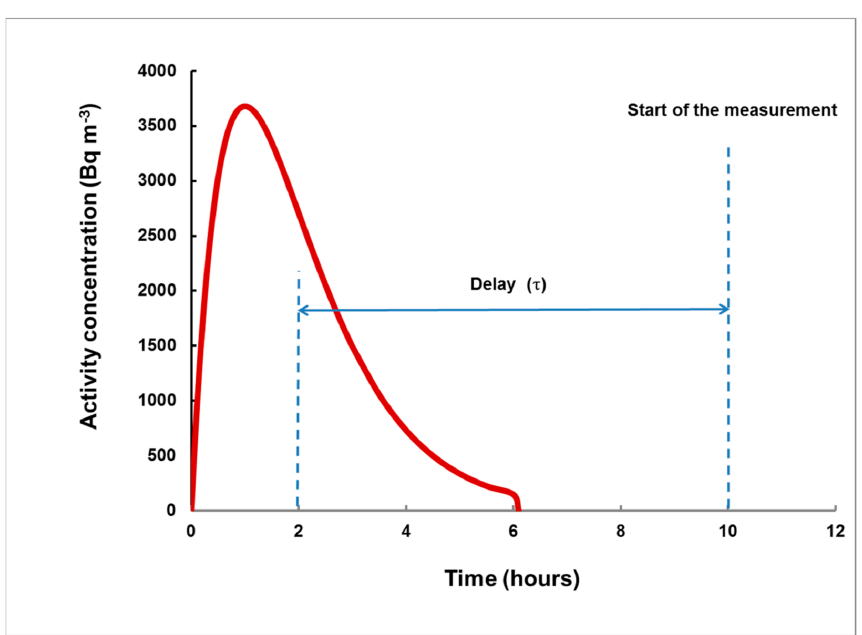
(cid:82) (cid:82) tc A dt / c A dt